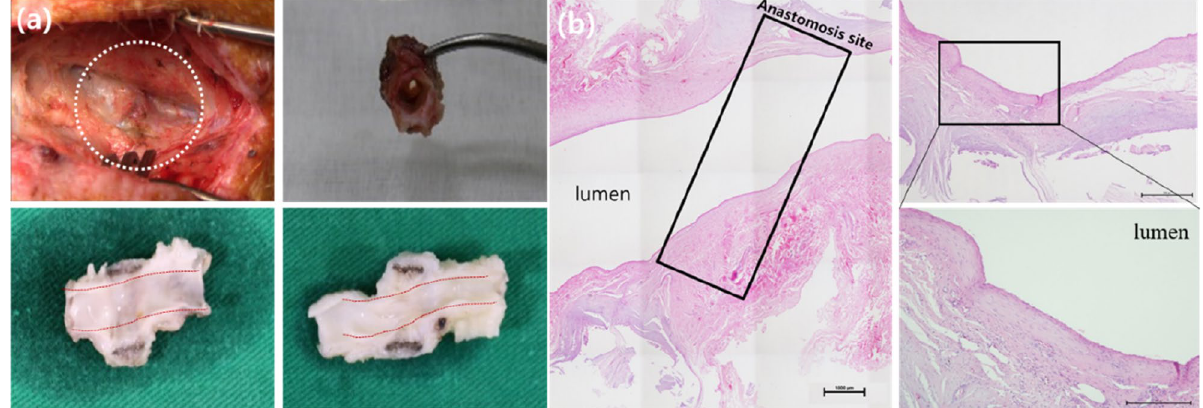
Figure 5. Representative ( a ) macro-photographic image and ( b ) haematoxylin and eosin staining at 12 weeks postoperatively. Macro-photographic and histological and findings of the vascular connection site showed that the titanium vascular anastomotic device (TVAD) was well attached to the outer wall of the vessel, the vessel lumen had no damage, and the inner wall of the vessel was completely endothelialised. There was no evidence of a profound foreign body reaction at the site of anastomosis when the TVAD was used. Moreover, the intima-to- intima contacts were clear (the region containing the anastomotic site is indicated by a